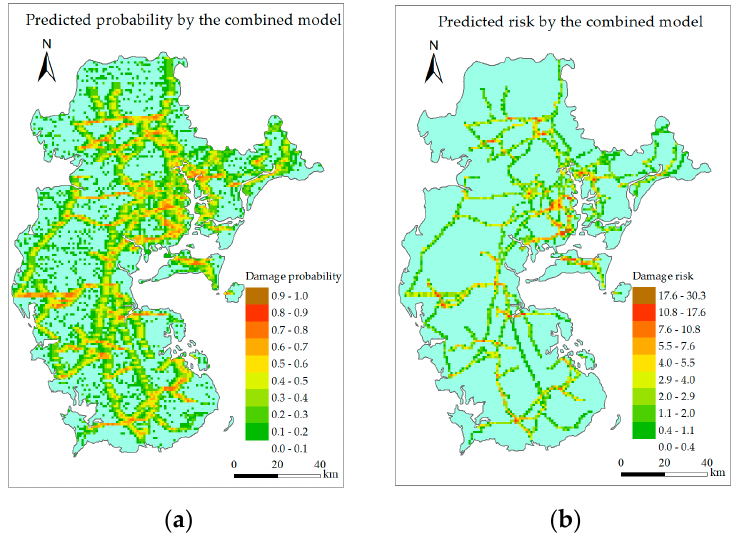
Figure 16. Prediction results of the combined model. ( a ) Predicted damage probability. ( b ) Predicted damage risk.